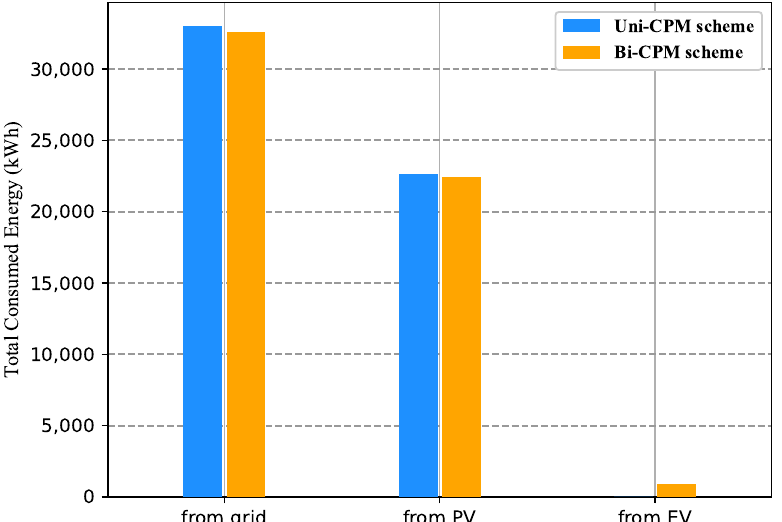
Figure 10. Total household electricity consumption provided in case 2 under Uni-CPM and